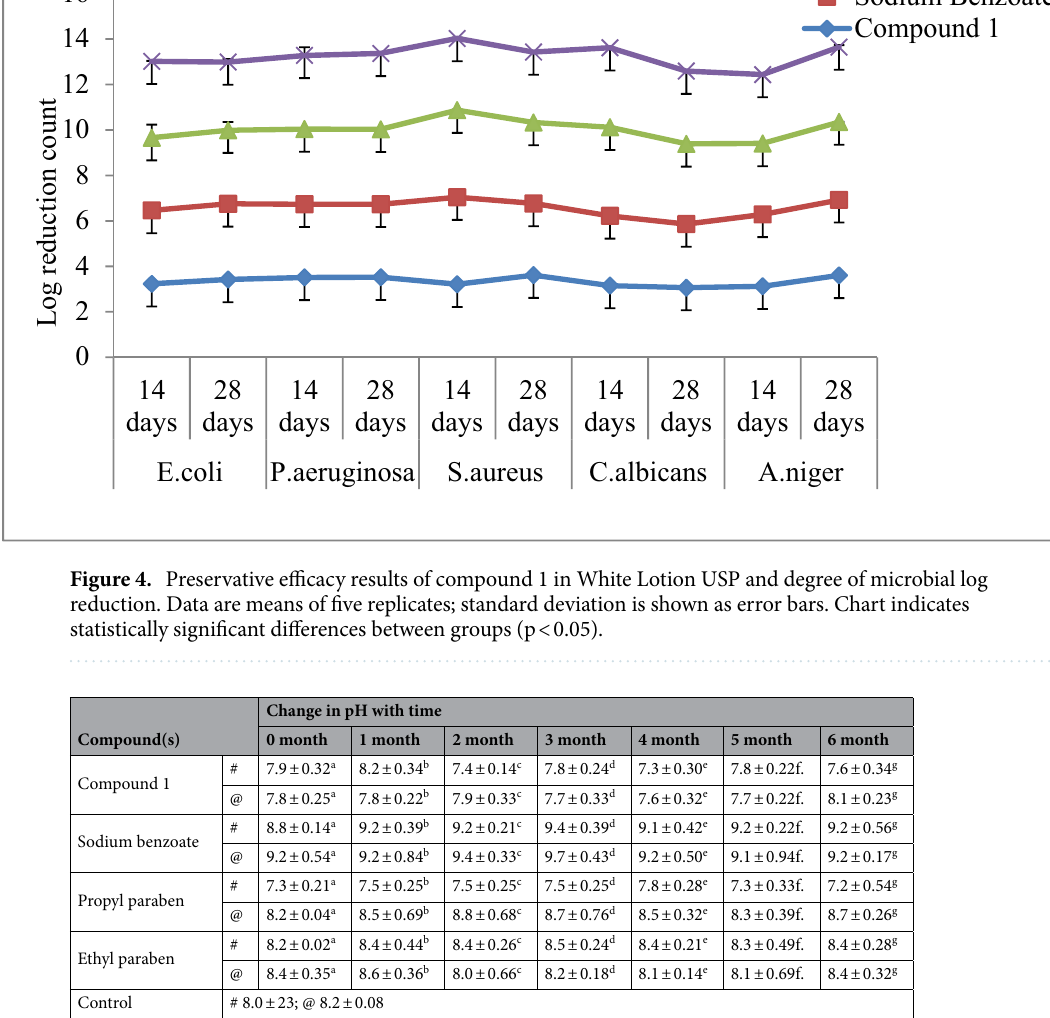
Table 3. Stability studies of compound 1 in Aloe vera juice and White Lotion USP for pH. # Aloe vera juice; @ White lotion USP. All pH values were recorded in triplicate (n = 5) and the mean values are presented. Different letters mean p < 0.05 in each line by Kruskal–Wallis